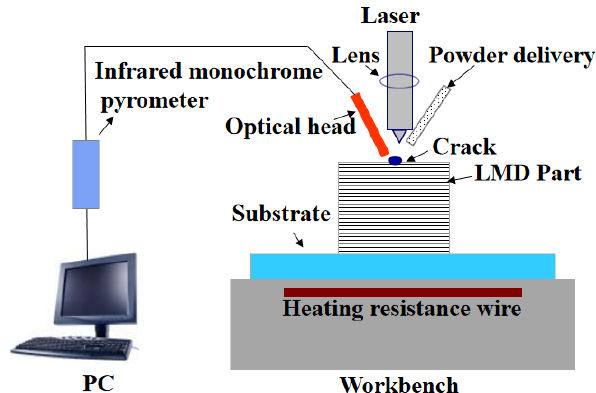
Figure 1. Schematic diagram of crack detector configuration using the IMP.